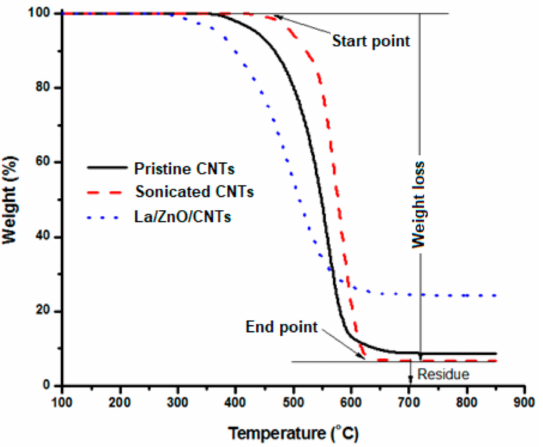
Figure 6. TGA profiles of pristine CNTs, sonicated CNTs and La/ZnO/CNTs composite